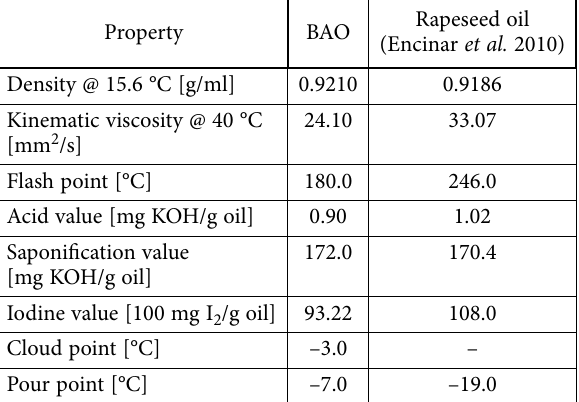
Table 1. Properties of BAO compared to rapeseed oil Property